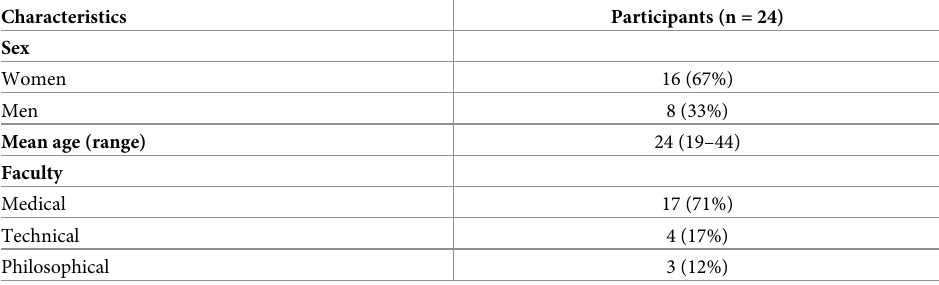
Table 1. Participant